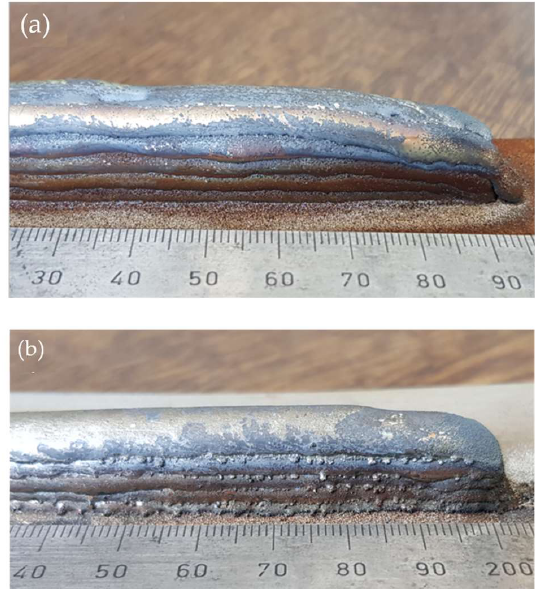
Figure 12. General view of additive manufactured wall by conventional PTA stringer ( a ) and paral- lel configuration tandem PTA ( b ) methods